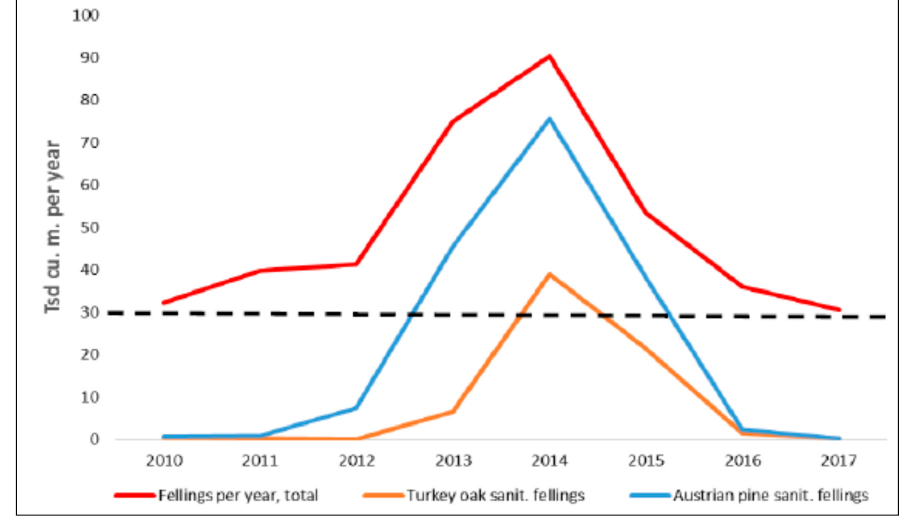
Figure A3. Total annual harvest (tsd. cu. m per year) including sanitary felling of two main tree species in the Keszthely forest district following a single drought event (2011–2013). Fellings surpassed the planned annual allowable cut (broken line; 30 tsd. cu.m per year) by three times the amount (data source: A. Jagicza, Bakonyerd˝o State Forest